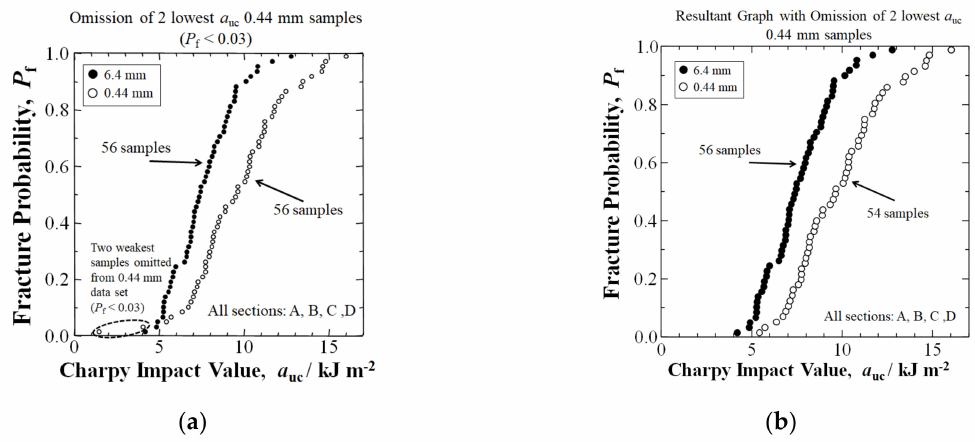
Figure 11. ( a ) Depiction of Figure 4a (all sections cumulative) indicating the 2 lowest a uc samples ( P f < 0.03) to be omitted from the 0.44 mm data set for re-evaluation. ( b ) Resultant graph with omission of 2 lowest a uc 0.44 mm samples, showing relationships between a uc and P f